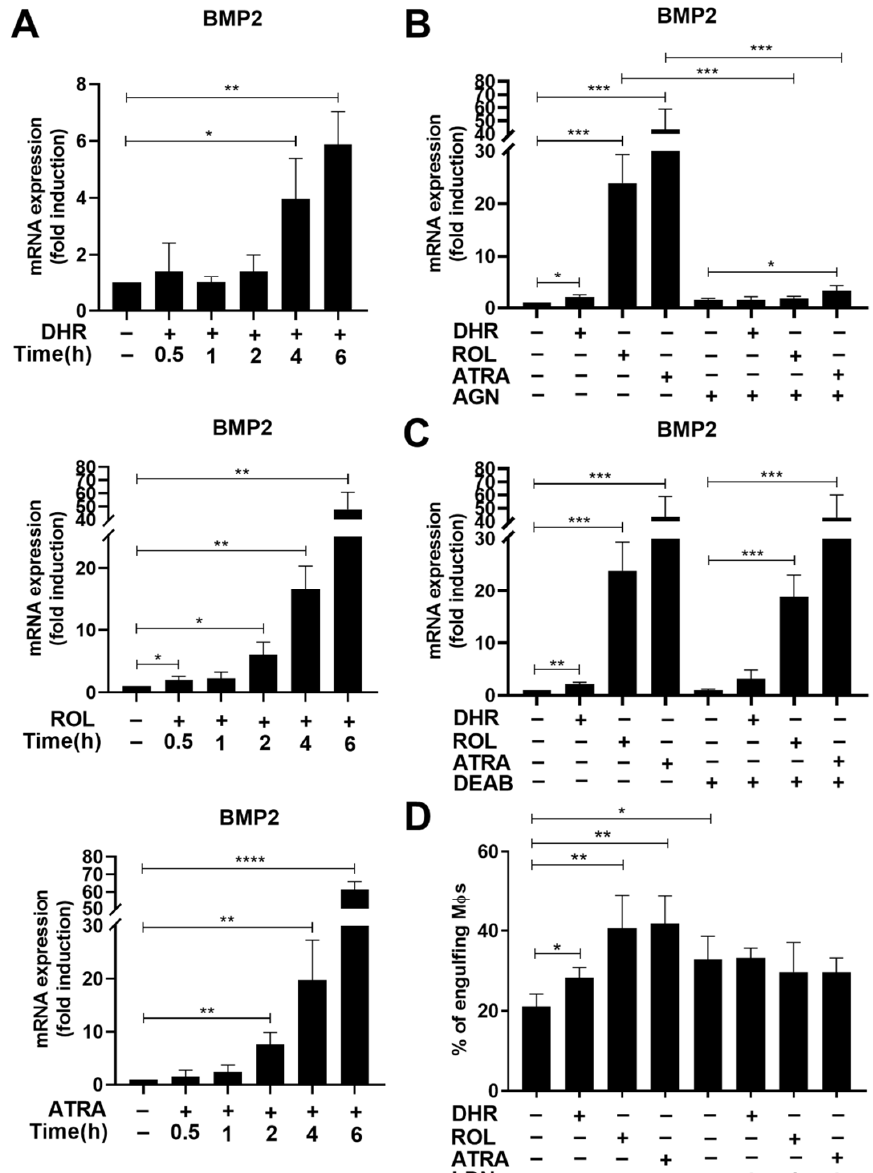
Figure 3. BMP-2 is induced by retinoids during macrophage differentiation and contributes to the retinoid-enhanced efferocytosis. ( A ) Time-dependent increase in the BMP-2 mRNA expression of differentiating macrophages exposed to 1 μ M DHR, 1 μ M ROL, or 30 nM ATRA at day 4 of differentiation. ( B ) Inhibition of retinoid-induced BMP-2 mRNA expression by AGN194310 (0.5 μ M) detected at 6 h after retinoid administration in day 4 differentiated macrophages. ( C ) Inhibition of retinaldehyde dehydrogenases by DEAB (25 μ M) has no effect on the retinoid-induced BMP-2 mRNA expression detected at 6 h after retinoid administration in day 4 differentiated macrophages. ( D ) LDN193189 (0.3 μ M), a BMP inhibitor, added together with the retinoids from day 4 of macrophage differentiation attenuates the induction of efferocytosis by retinoids detected 2 days later. All data are expressed as mean ± SD ( n = 4). B-actin was used as a reference gene for all qRT-PCR determinations. Asterisks indicate statistically significant difference (* p < 0.05, ** p < 0.01, and *** p < 0.001, and **** p < 0.0001). Each culture contained 0.5% v / v DMSO.